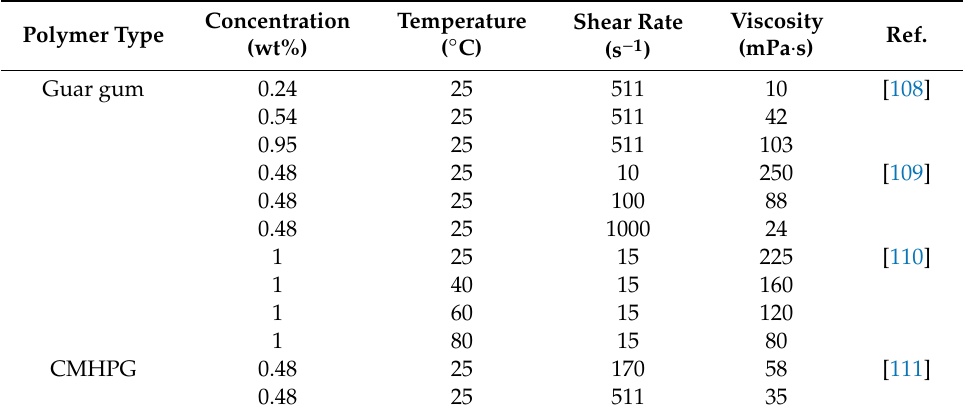
Table 4. The viscosity of biopolymer under various